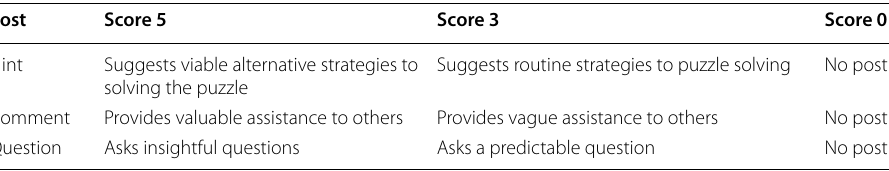
Table 3 Discussion Board Rubric